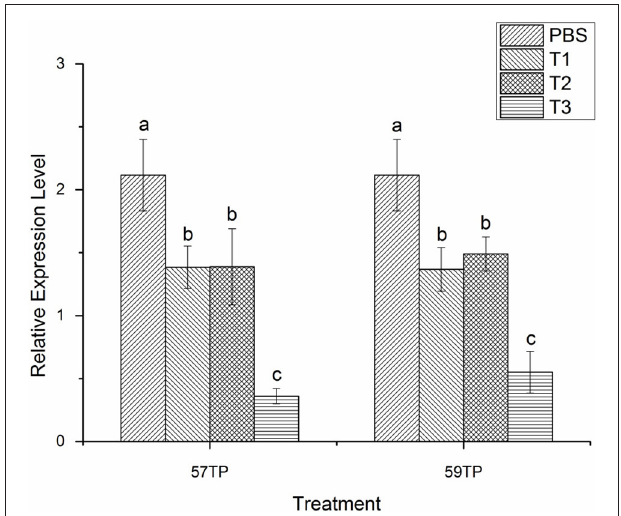
FIGURE 3 | The mRNA expression levels of CGI_10012534 gene in the mantle of oyster after RNAi. Notably, 57TP indicates the siRNA-57 targeted treatment group, 59TP indicates the siRNA-59-targeted treatment group; PBS indicates the group treated with phosphate-buffered saline (PBS) ( n = 6), T1 indicates the group treated with 5 µ g/100 µ l siRNA ( n = 6), T2 indicates the group treated with 10 µ g/100 µ l siRNA ( n = 6), and T3 indicates the group treated with 15 µ g/100 µ l siRNA ( n = 6). Each bar represents the mean of 6 independent experiments performed in duplicate. Different letters indicate significant difference ( P < 0.05).